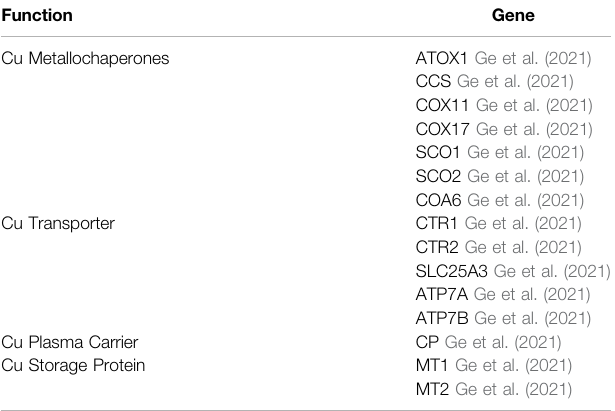
TABLE 1 | Genes responsible for copper homeostasis within the human body. Function